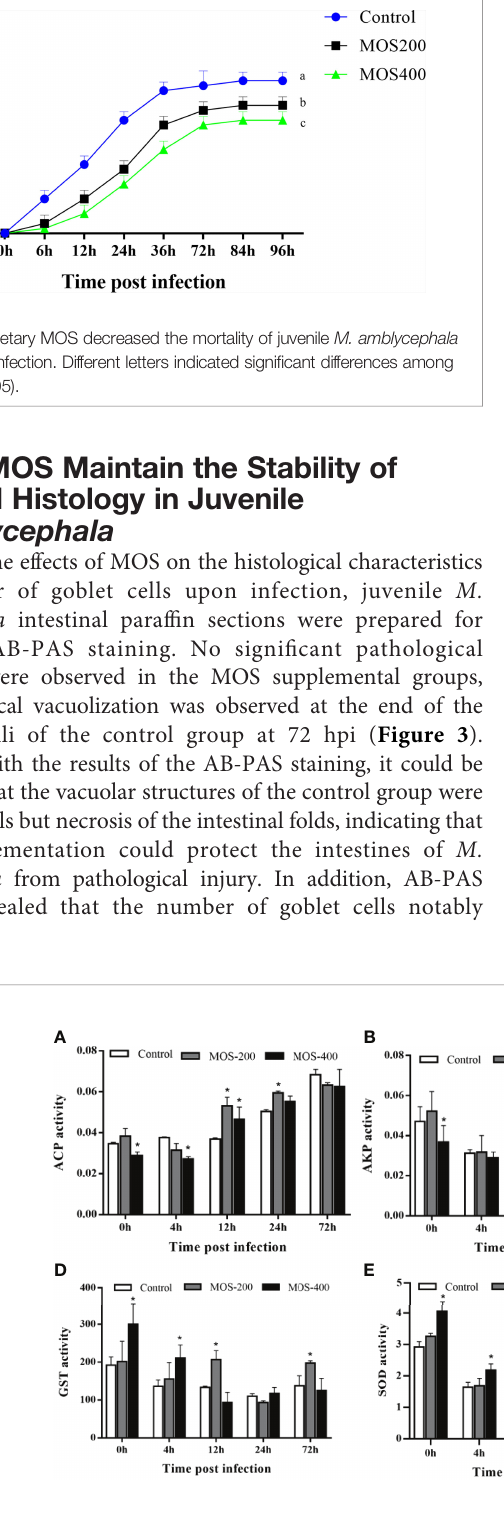
FIGURE 2 | Effects of MOS supplementation on the activities of hepatic antimicrobial and antioxidant enzymes of juvenile M. amblycephala . (A – F) showed the enzymes activity of ACP, AKP, LZM, GST, SOD, and CAT, respectively. The asterisks indicated statistically signi fi cant differences among different groups at a certain time point (P <